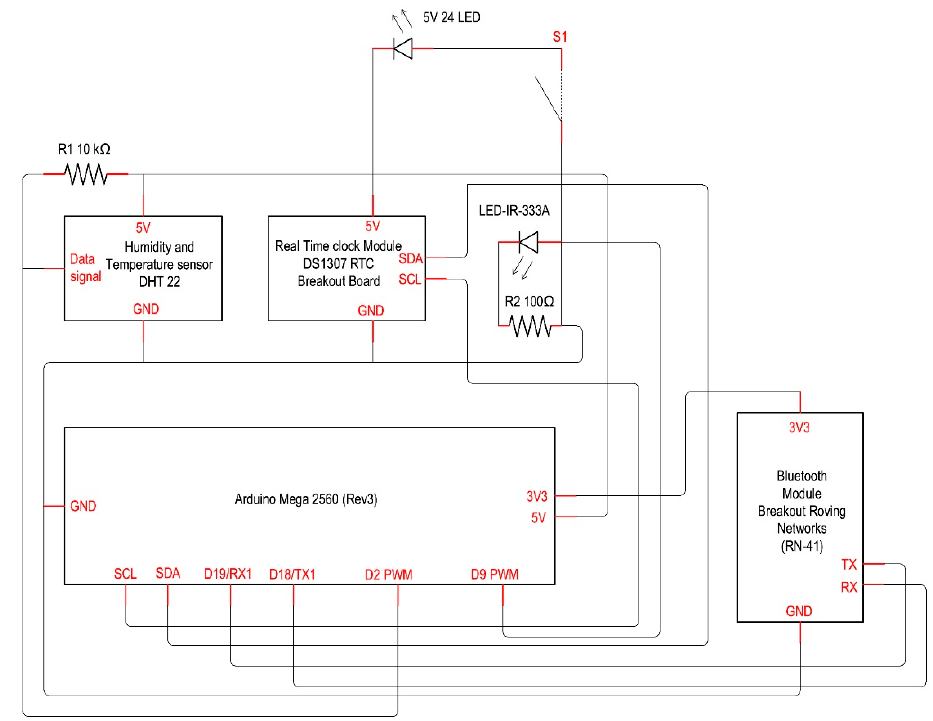
Figure 1. Smart Lamp: wiring diagram.